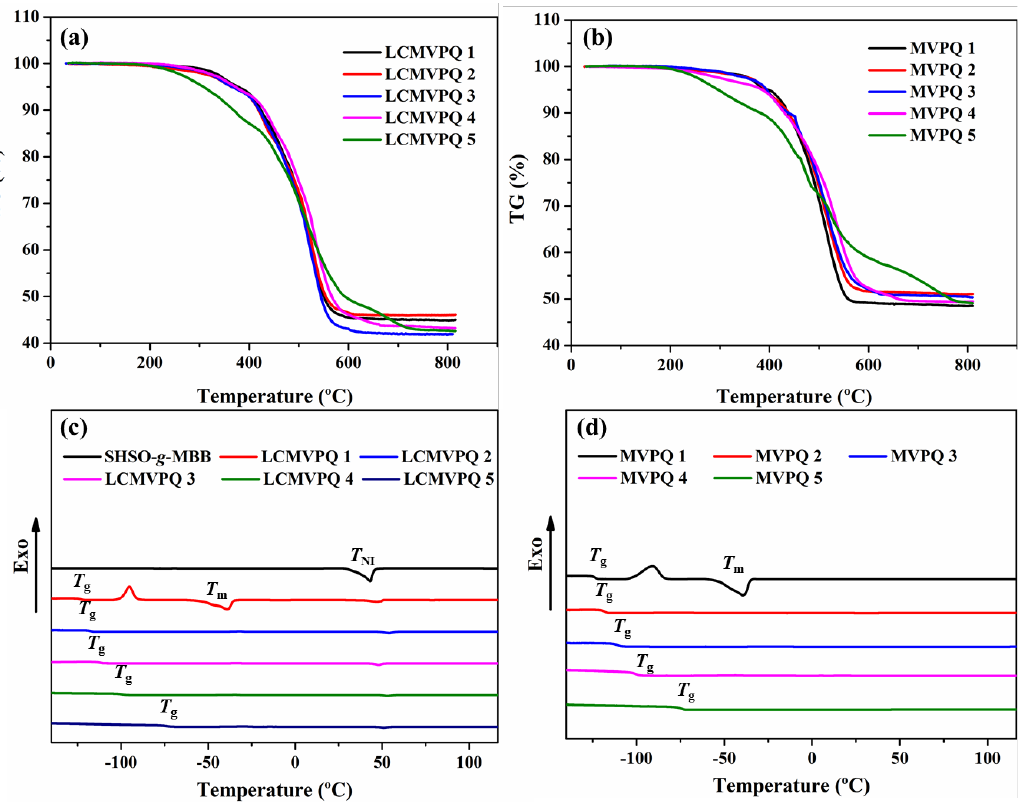
Figure 4. TGA curves of ( a ) all the synthesized LCMVPQs and ( b ) MVPQs; DSC traces of ( c ) SHSO- g -MBB and all the LCMVPQs and ( d) MVPQs. Table 4. Summary of 5%, 10%, maximum weight loss temperature and 800 °C residual weight.